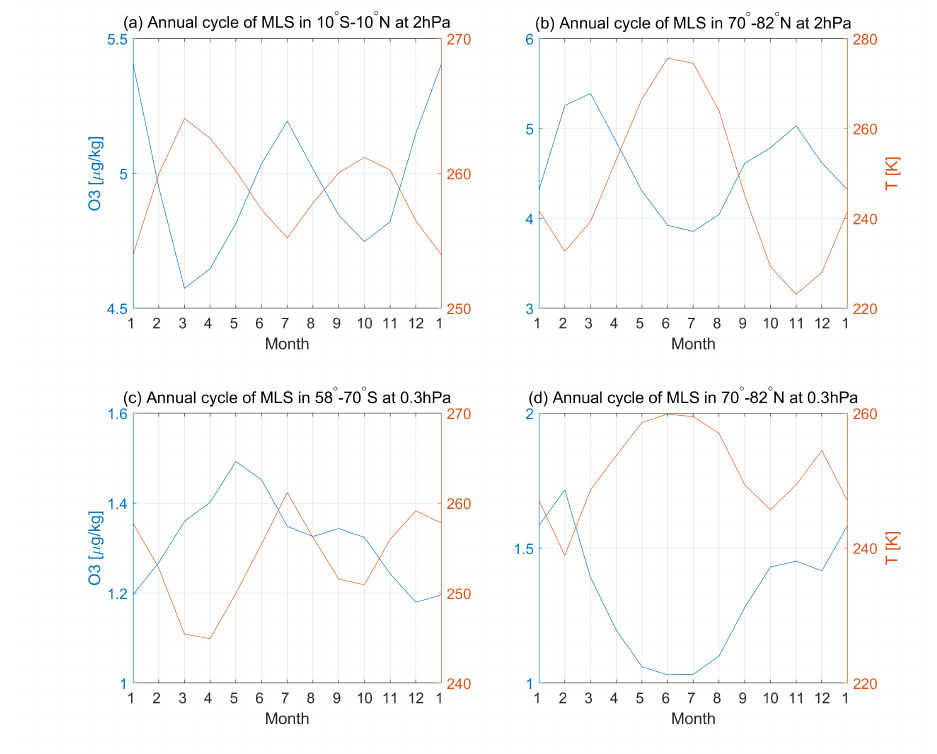
Figure 7. The monthly annual mean MLS ozone (blue)/temperature (orange) at 2 hPa for the tropical region (10 ◦ S–10 ◦ N) ( a ), the NH high latitudes (70 ◦ N–82 ◦ N) ( b ), the SH high latitudes (58 ◦ S–70 ◦ S) ( c ) at 0.3 hPa and the NH high latitudes (70 ◦ N–82 ◦ N) at 0.3 hPa ( d ) in the period